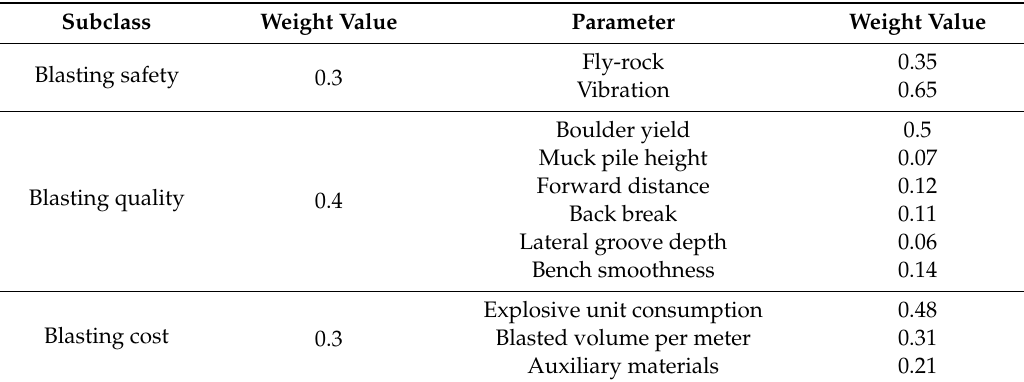
Table 4. Weight values of